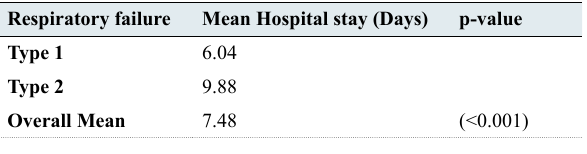
Table 4: Mean hospital stay among various arterial blood gas